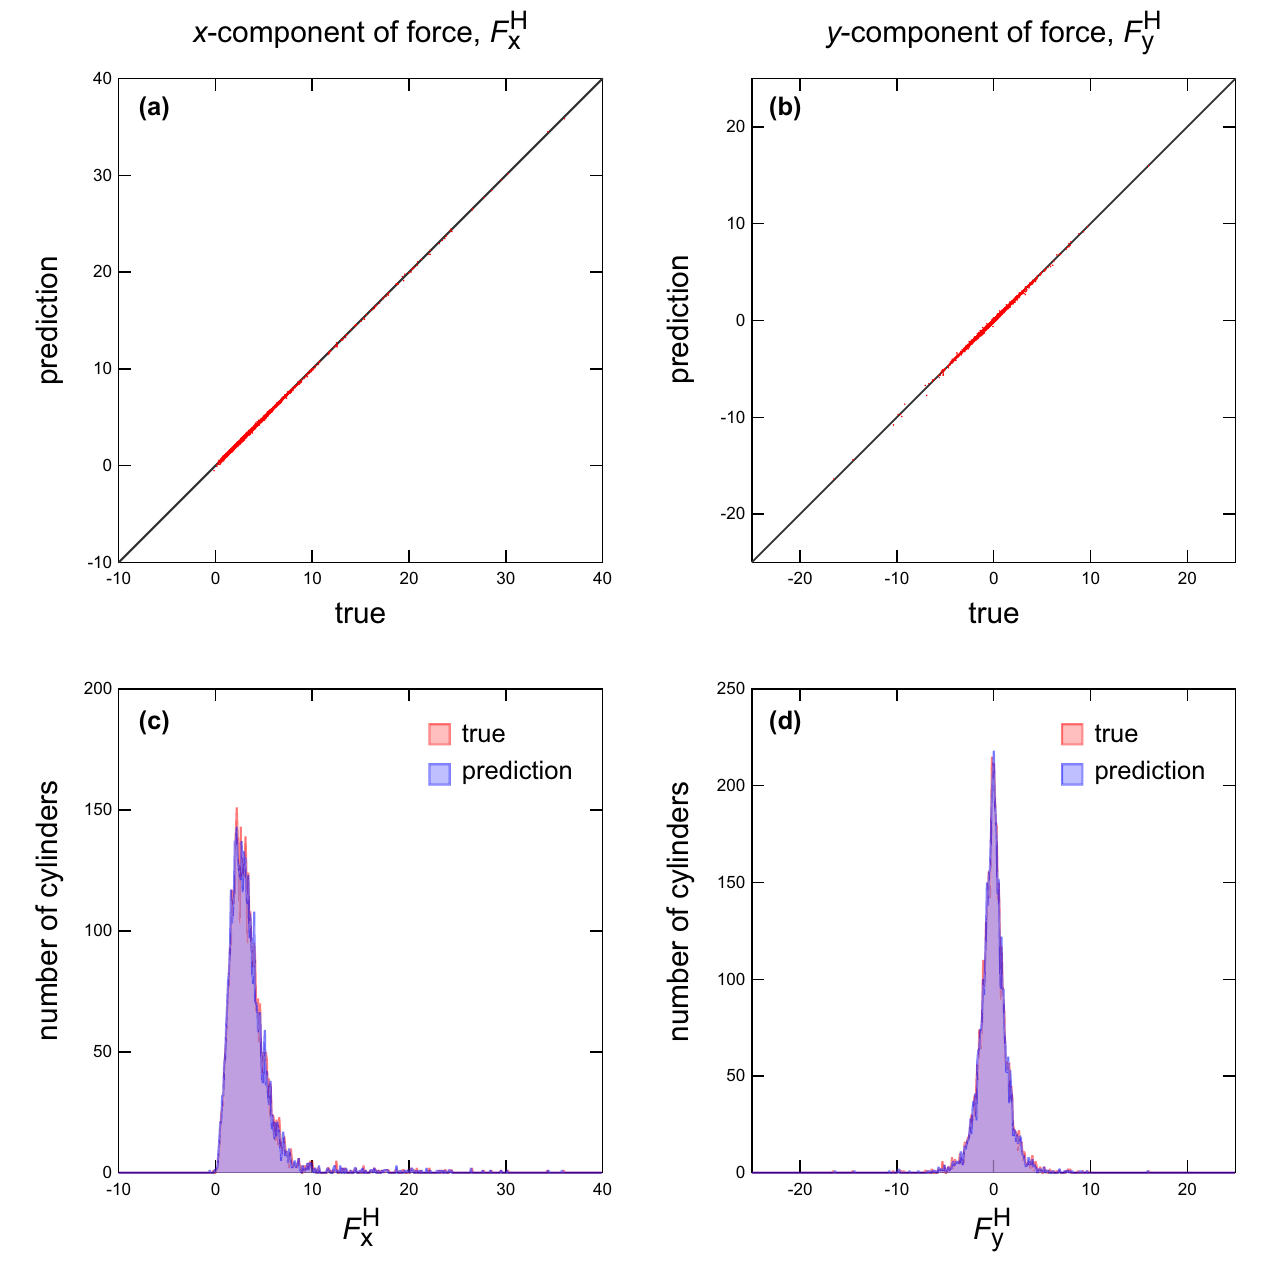
Figure 7. Scatter plots ( a , b ) and histograms ( c , d ) of the true and predicted forces acting on each cylinder. 48 . The figure shows the gathered results of 100 patterns of the cylinder The number of cylinders is set at N = arrangement. ( a ) Scatter plot of the x -components of the true and predicted forces acting on each cylinder. ( b ) Scatter plot of the y -components of the true and predicted forces acting on each cylinder. ( c ) Histograms of x -components of the true (red) and predicted (blue) forces acting on each cylinder. ( d ) Histograms of y -components of the true (red) and predicted (blue) forces acting on each